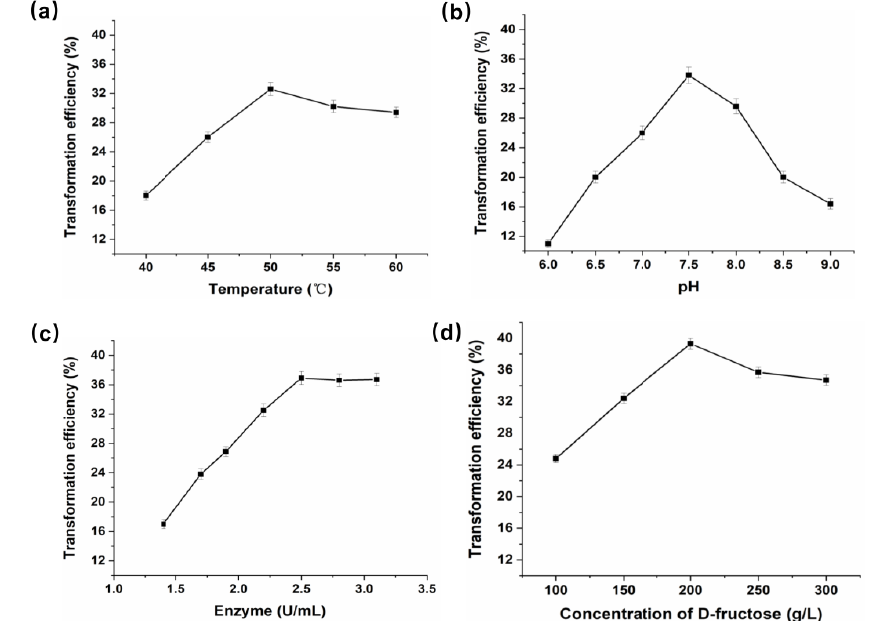
Figure 4. Effects of temperature, pH, enzyme concentration, and substrate concentration on D- mannose production. ( a ) Optimal temperature. The reactions were performed in 50 mM sodium phosphate buffer (pH 7.5) at 40–60 °C with 20% D -fructose and 2.5 U·mL −1 P. geniculata AGEase; ( b ) Optimal pH. The reactions were performed in 50 mM sodium phosphate buffer (pH 6.0–9.0) at 50 °C with 20% D-fructose and 2.5 U·mL −1 P. geniculata AGEase; ( c ) Optimal enzyme concentration. The D-fructose and 2.5 U · mL − 1 P. geniculata AGEase; ( c ) Optimal enzyme concentration. The reactions